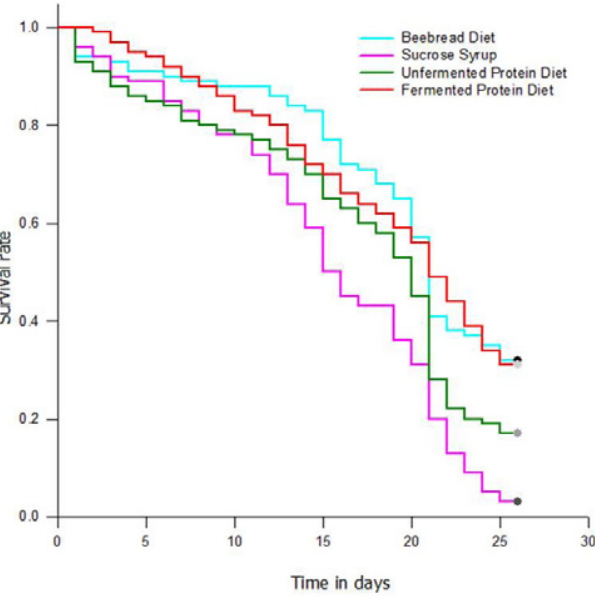
Fig 1 . Survival of caged newly emerged bees fed different diets in confinement cages. Diets were beebread, fermented protein diet, unfermented protein diet and sucrose syrup.